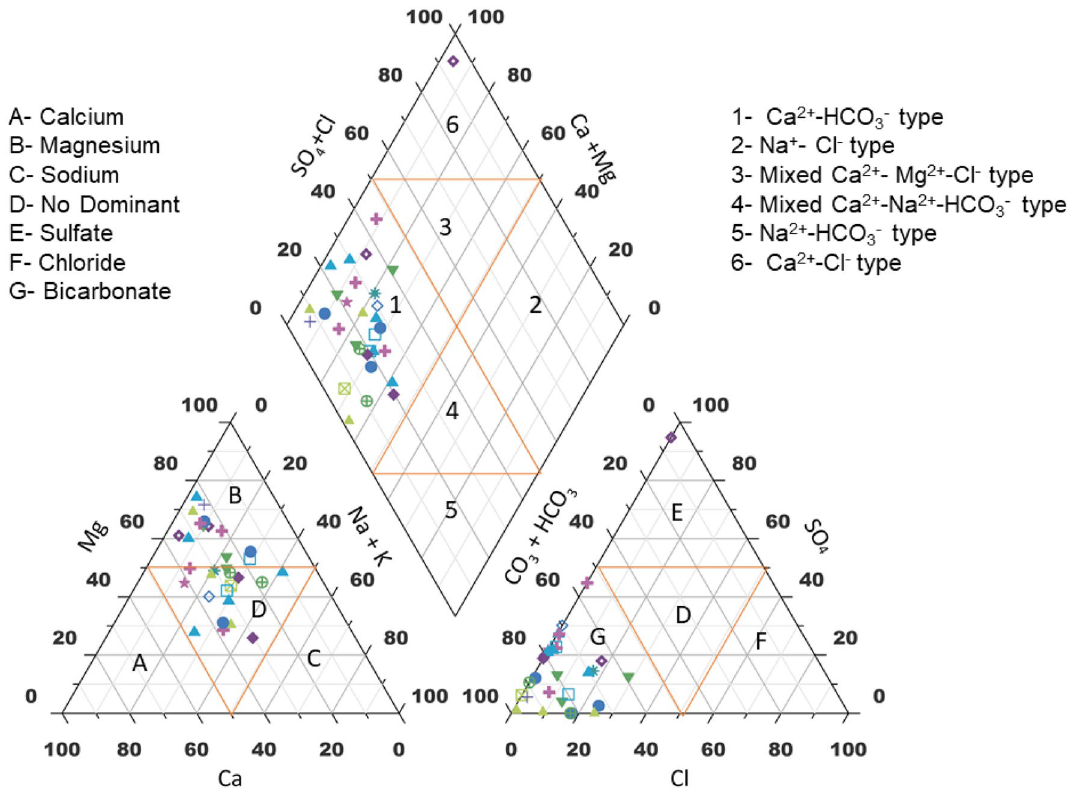
Figure 7. Hill Piper trilinear